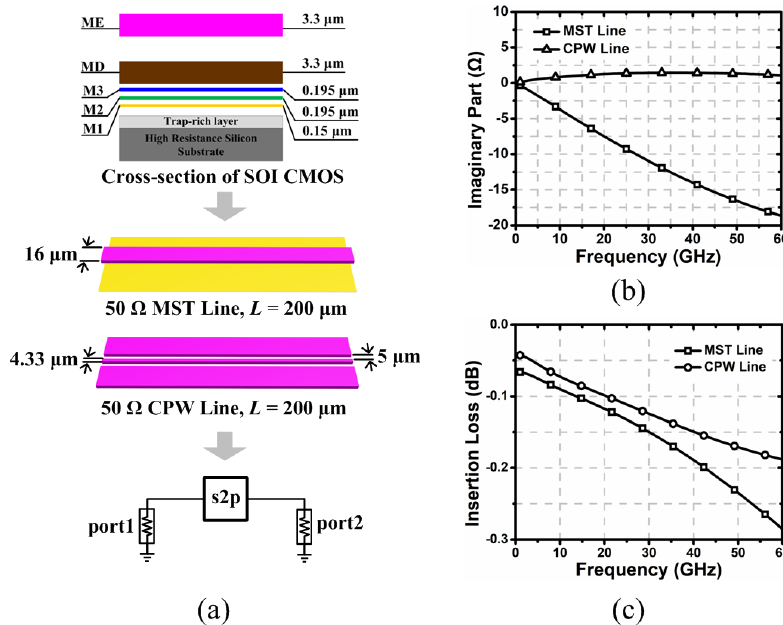
Figure 2. ( a ) The cross-section of the 90nm SOI-CMOS technology, a 200 μ m, 50 Ω microstrip (MST) line, a 200 µ m, 50 Ω coplanar waveguide (CPW) line, and the simulation setup, ( b ) the line, a 200 μ m, 50 Ω coplanar waveguide (CPW) line, and the simulation setup, ( b ) the simulated imaginary part of the impedance seen from port1, ( c ) simulated attenuation of CPW line and MST line.